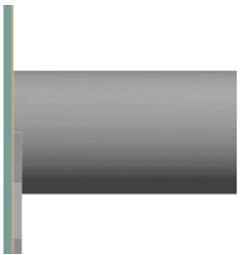
Figure 2. Side view of a part of the simulated geometry near the inlet. Visible are inlet of the inflow zone (grey), the very thin membrane zone (orange) and the outflow zone (green). Given the sharp corners of the spacer, the spacer “curviness” was used as a measure